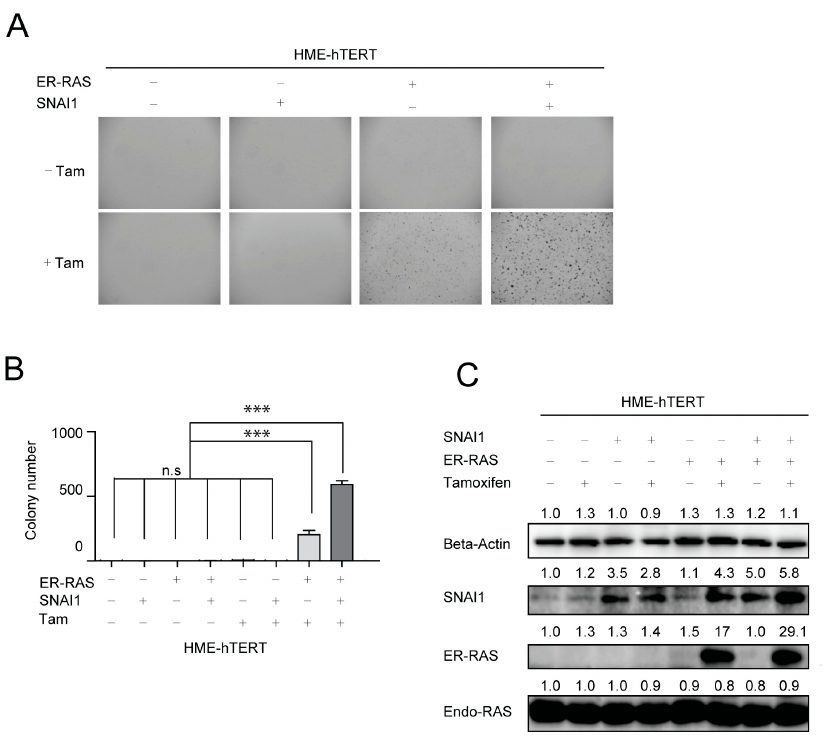
Figure 4. Mutant-RAS-driven cell proliferation in soft agar requires the upregulation of epithelial- mesenchymal transition (EMT). ( A ) Representative microscopic images of HME-hTERT cells grown in soft agar with or without the exogenous expression of CA-NRAS and/or SNAI1. ( B ) Quantitation of the data from panel A. Data are presented as mean ± SD of the number of colonies counted in three separate fields from each condition *** p ≤ 0.001, n.s: Not Significant, (Student’s t -test). The study presented has been repeated with similar results. ( C ) Immunoblot analysis of the indicated proteins in samples extracted from soft-agar cultures of HME-hTERT cells, which are cultured either in the presence or absence of exogenous expression of SNAI1 and/or CA-NRAS, as